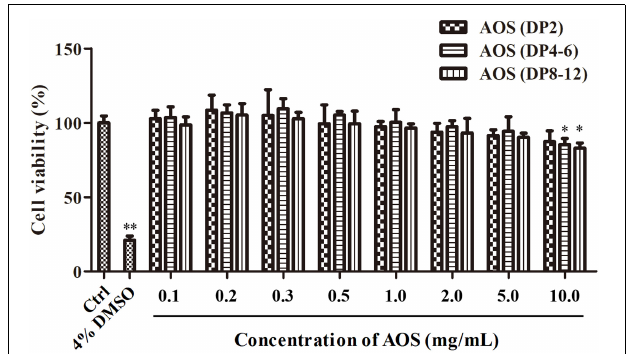
FIGURE 2 | Proliferation of cultured human hair follicle dermal papilla cells (hHFDPCs) treated with algal oligosaccharide (AOS) of varying doses. Different concentrations of AOS were added into cultured hHFDPCs, and cell viability was determined by 3-(4,5-dimethylthiazol-2-yl)-2,5-diphenyltetrazolium bromide assay. As a positive control, 4% dimethyl sulfoxide was included. Columns represent the mean of triplicate assays. Results that are significantly different from those in the blank control group are shown by asterisks ( ∗ p < 0.05, ∗∗ p <